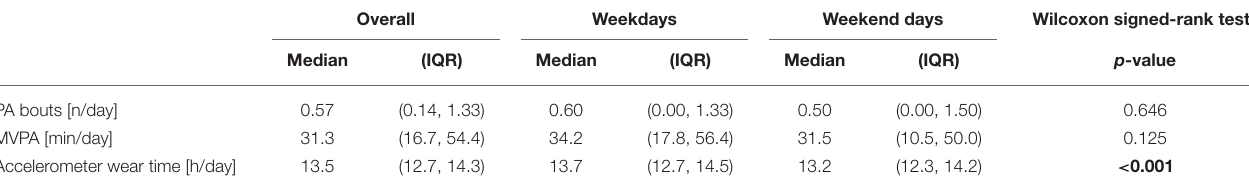
TABLE 2 | Accelerometer-derived PA and wear time overall (all days) and on weekdays and weekend days ( n = 167).